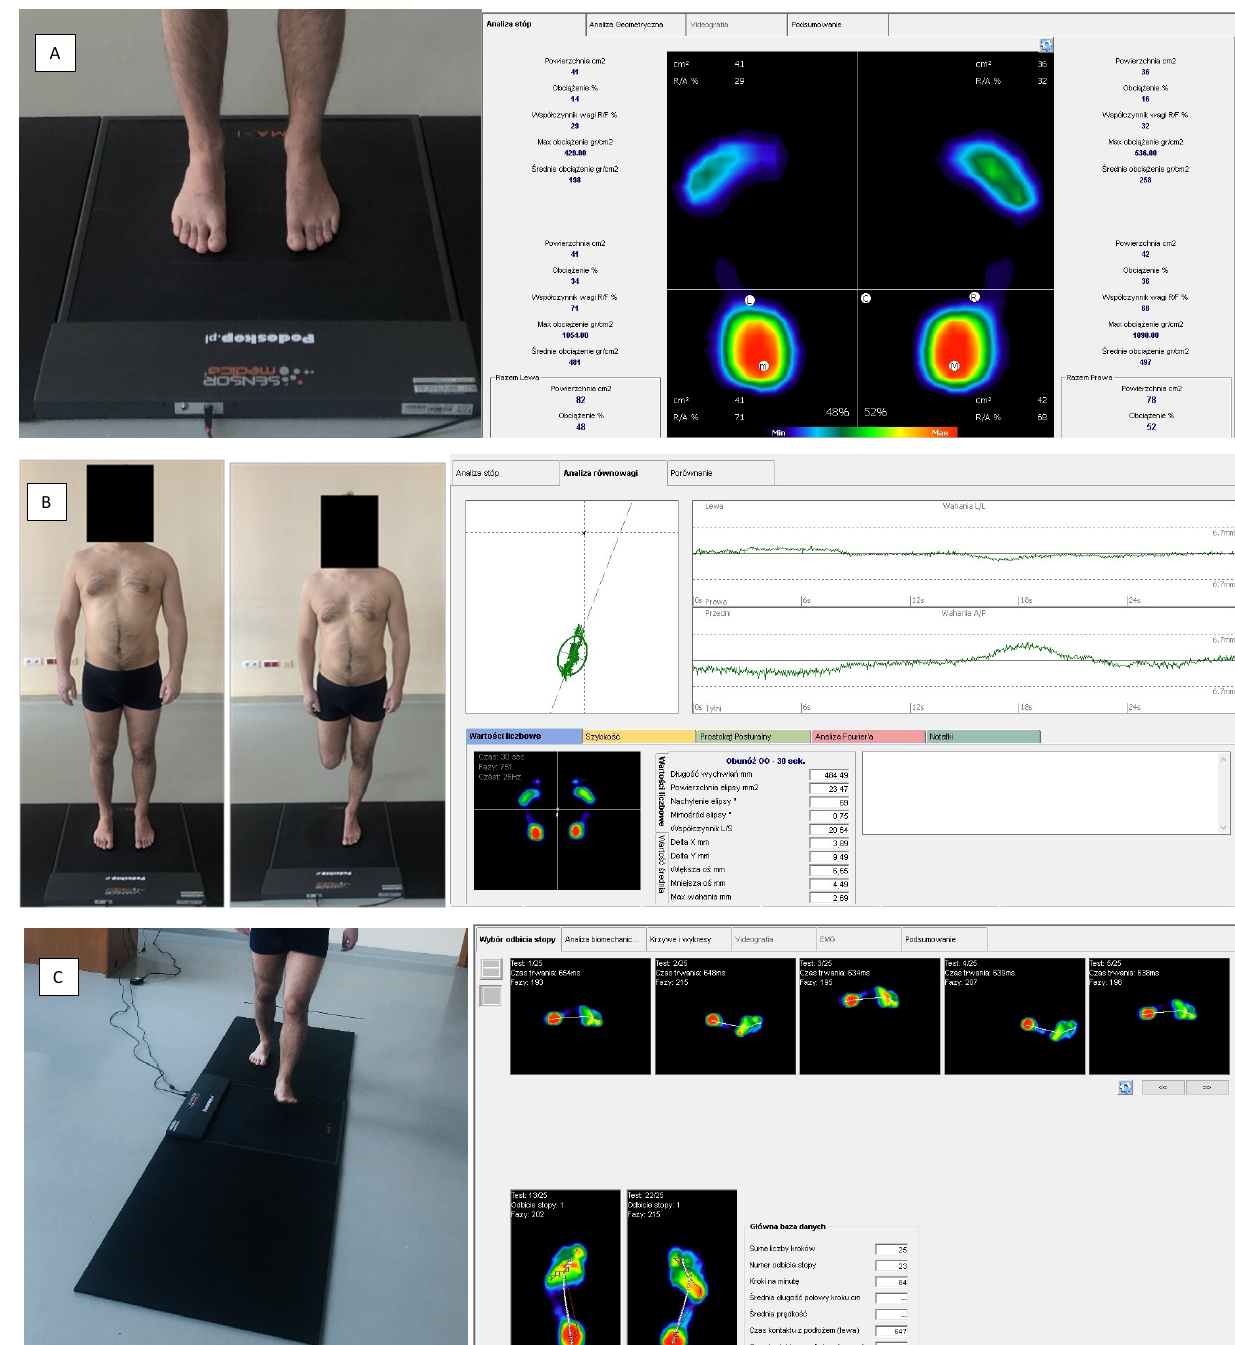
Figure 1. Measurement stand, equipped with a platform for evaluating ground reaction forces. (Free Med Base) during static ( A ), stabilographic ( B ) and dynamic ( C ) tests, along with sample reports from performed